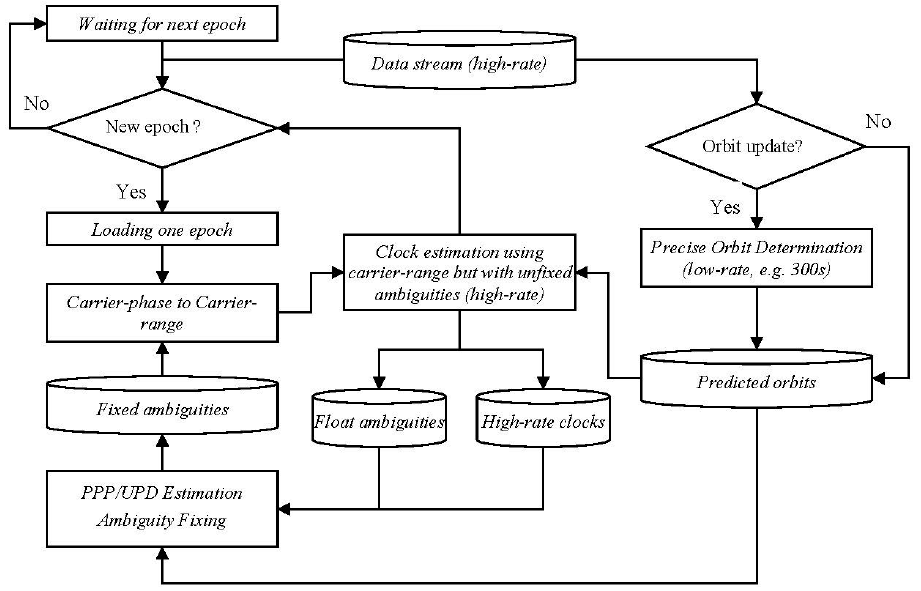
Figure 2. Overview on the estimation of clock corrections in real-time mode using